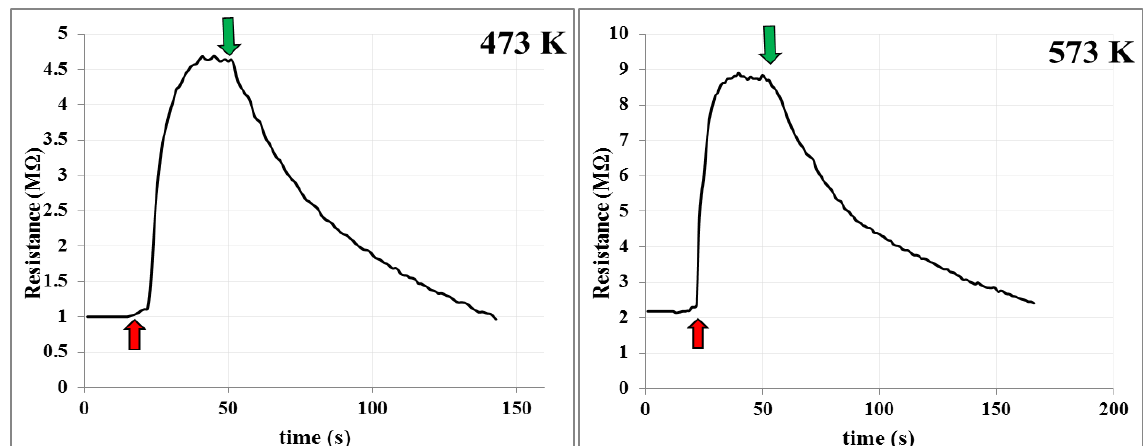
Fig. 8: Variation of with time for (SnO) gas at 473 and 573